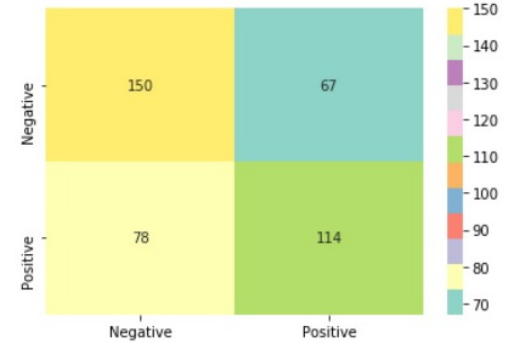
Figure 9. Process of splicing an image